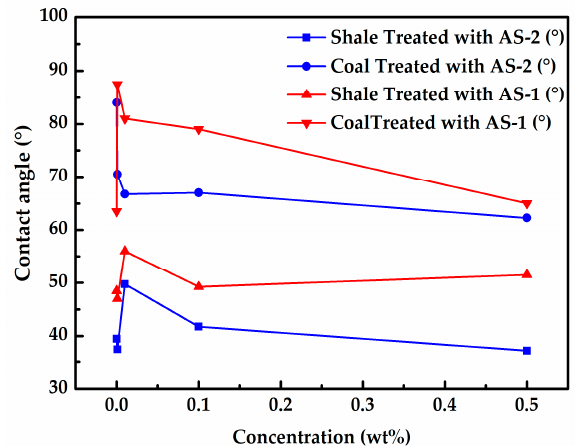
Figure 3. Relationship between surface tension vs surfactant concentration.